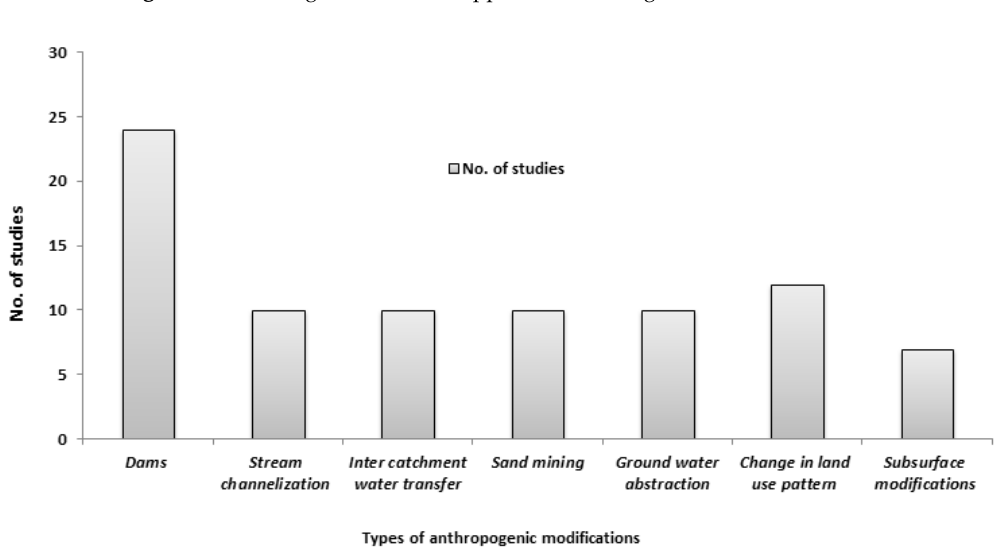
Figure 2. Flow diagram of review approach following the PRISMA method.